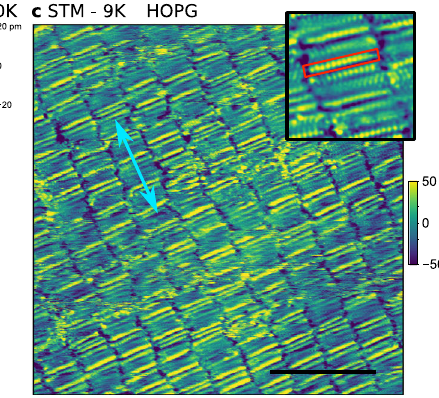
along the stripes. (Scale bar: 10nm). Inset: 6×6nm STM topography image showing the atomicscale structureof a molecular stripe. Single-moleculeisshown bytheredrectangle. d Schematicrepresentationofthelinearalkanemoleculesona graphenesurface.Inallimages,lightbluearrowsareparalleltothedirectionofthe stripes, identi fi ed by